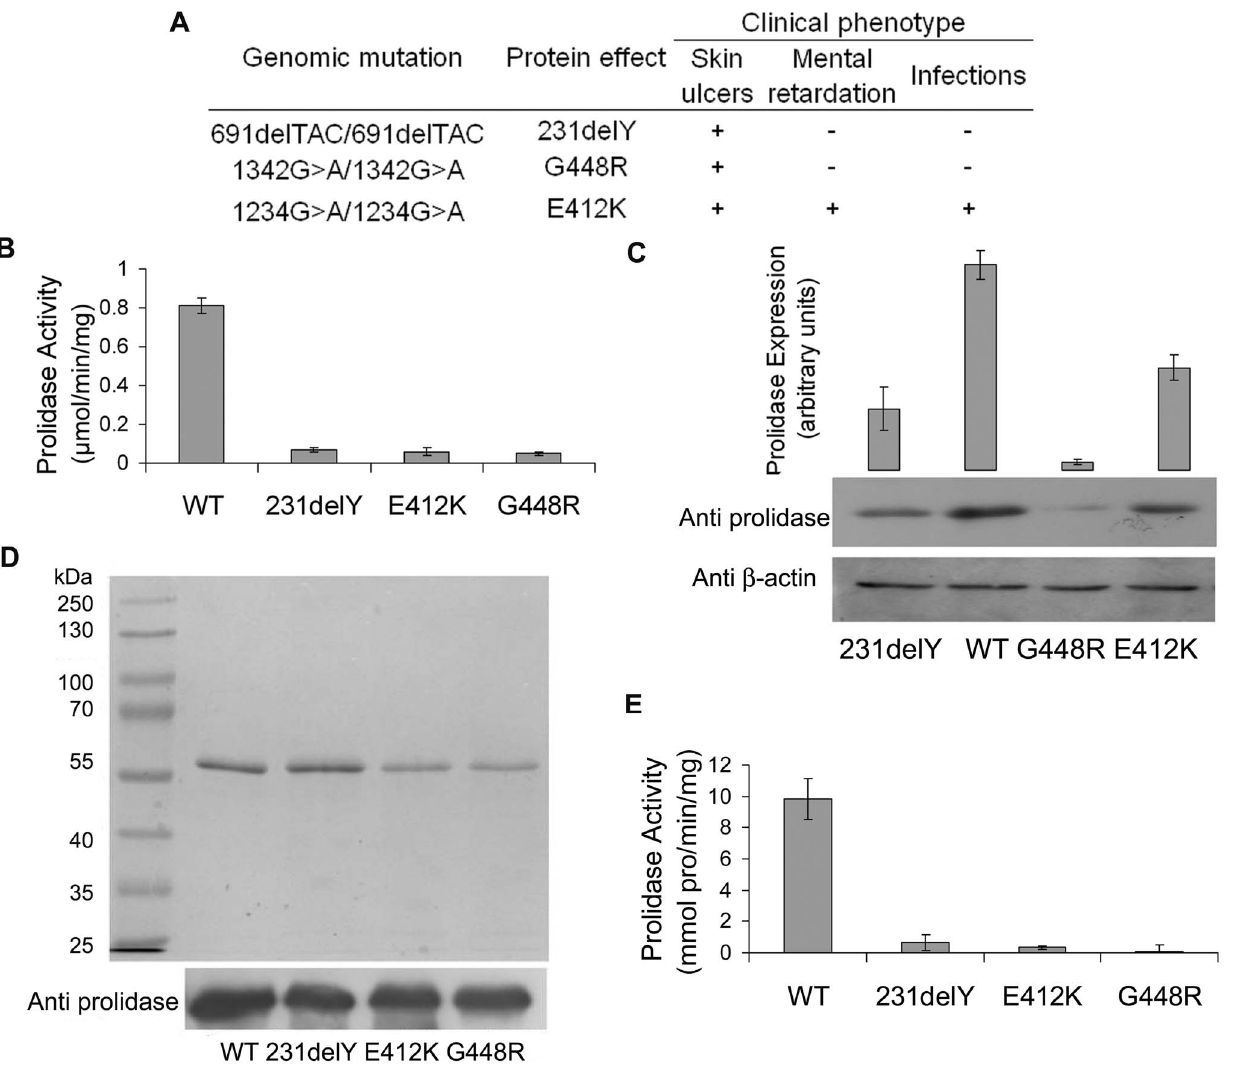
Figure 1. Human prolidase activity and protein expression. (A) Mutations and clinical phenotype of the PD patients used for the study. (B) Prolidase activity levels, and (C) prolidase expression levels in control (WT) and PD patients fibroblasts lysates (231delY, E412K, G448R). Densitometric analysis of Western blots (C, top) shown in the lower part of the panel. (D) SDS-PAGE (top) and Western blotting (bottom) of purified recombinant WT and mutant forms. (E) Prolidase activity of the recombinant proteins. ( Figure 1A ); we then produced and purified the respective recombinant enzymes ( Figure 1D ) for structural and kinetic characterization. All the selected mutations were located in the prolidase domain belonging to the M2 Metal Peptidase homology family.